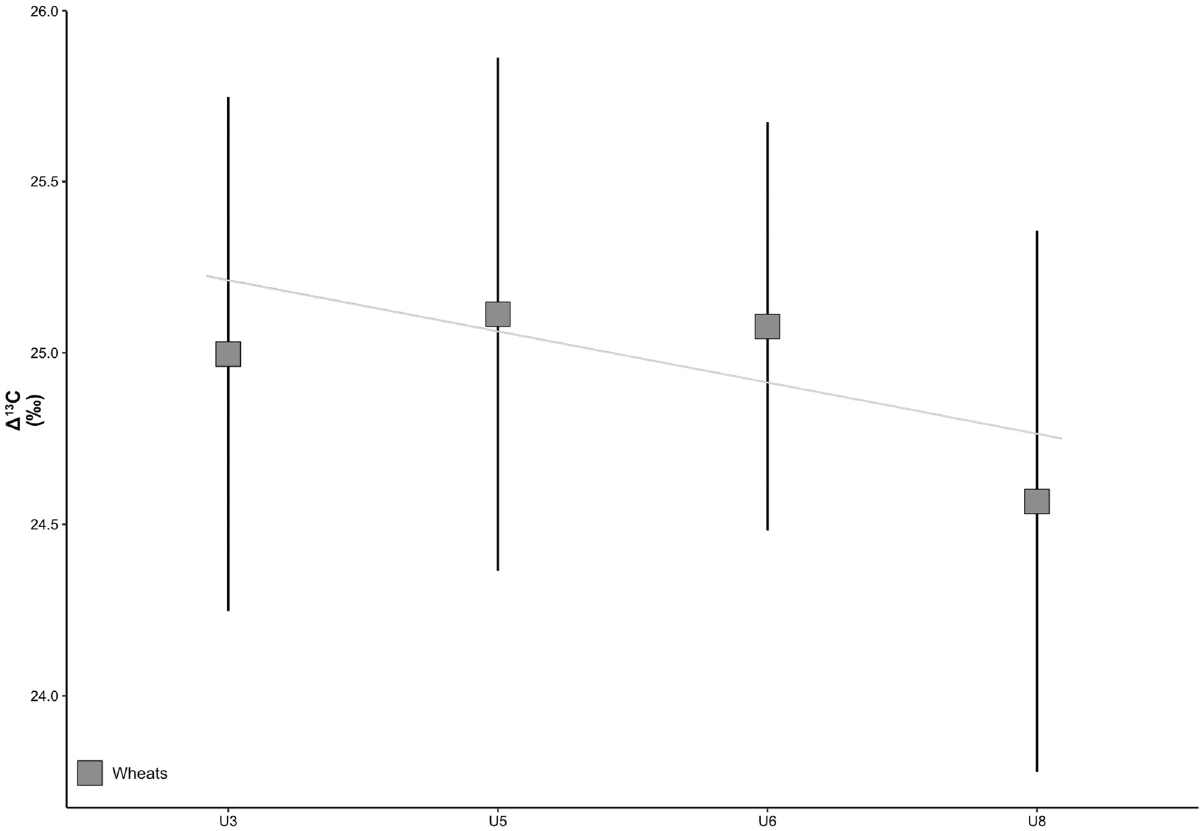
Fig 22. Δ 13 C values of wheats from units 3, 5, 6 and 8 of Zug-Riedmatt and the regression line. The higher Δ 13 C values suggest greater water availability.